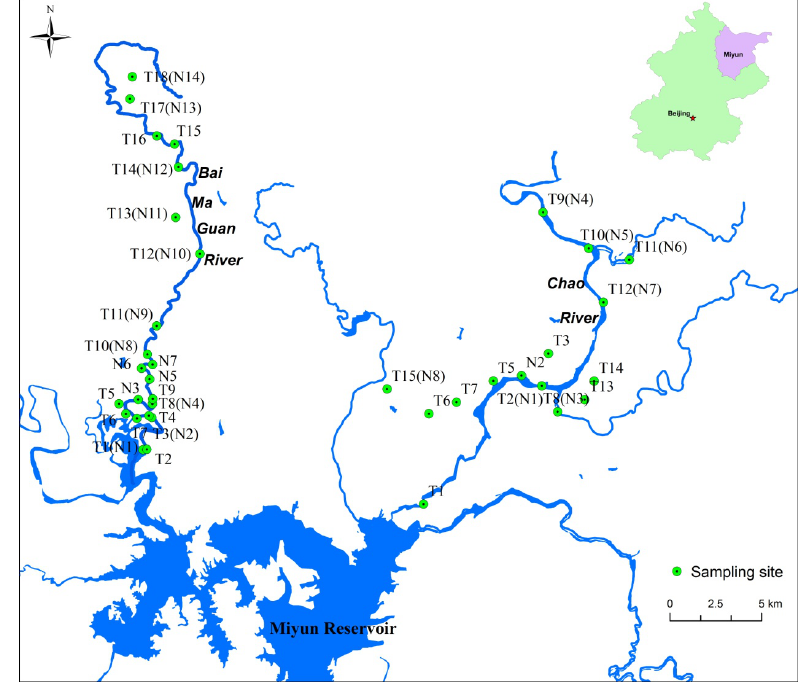
Figure 1. Distribution of sampling sites.